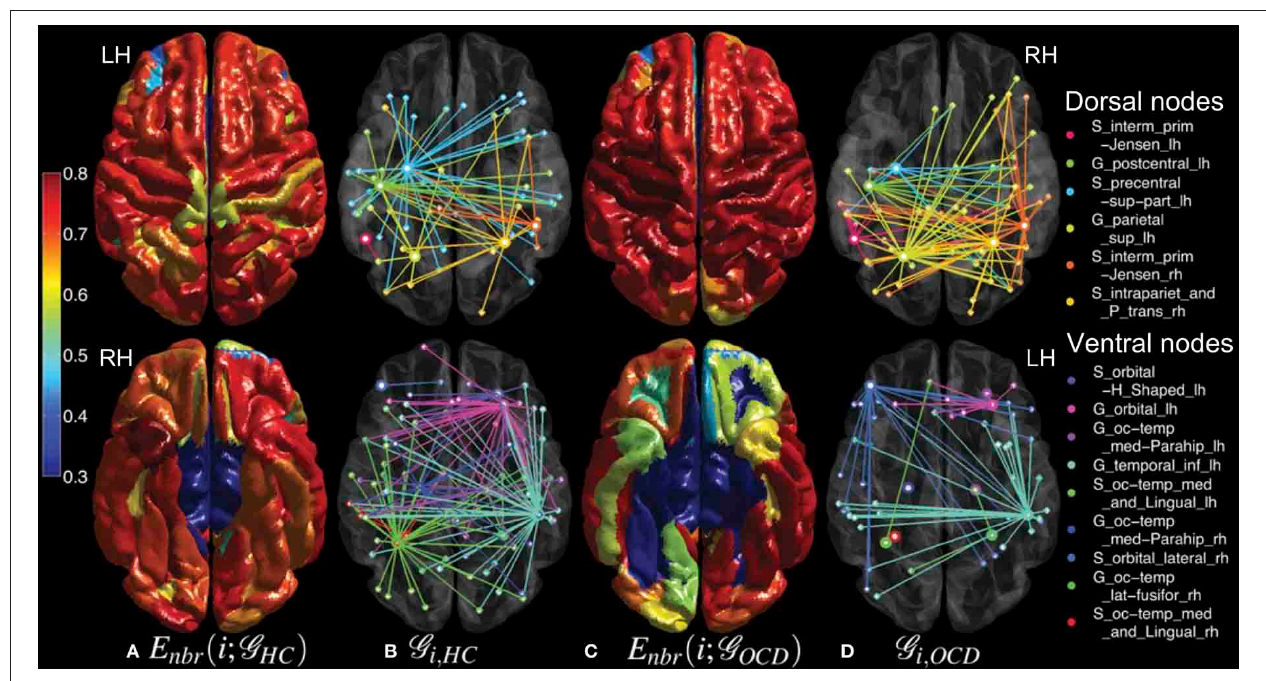
(HC, column B; OCD, column D) are shown in the same graphical scheme as Figure 5, except that the color coding range of neighboring efficiencies is adjusted from 0.3 to 0.8 for a better